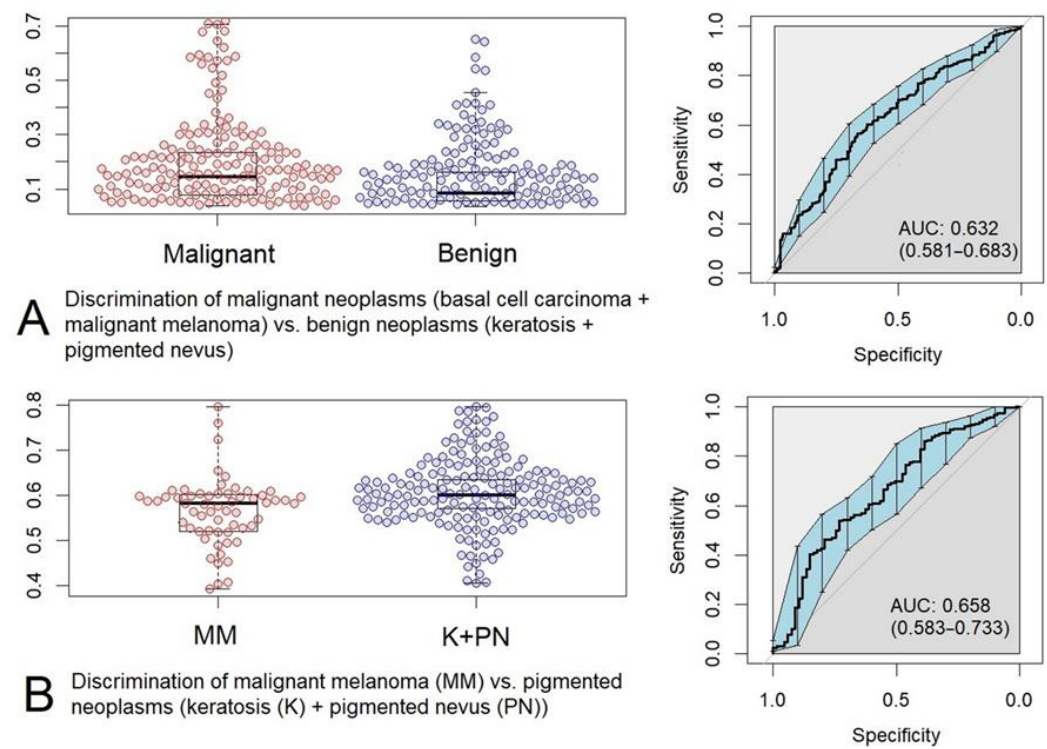
Figure 9. Box-plot diagrams and ROC-curves of the predicted values obtained as a result of PLS- DA: ( A ) malignant neoplasms (basal cell carcinoma + malignant melanoma) versus benign neo- plasms (keratosis + pigmented nevus), ( B ) malignant melanoma (MM) versus pigmented neoplasms (keratosis + pigmented nevus).